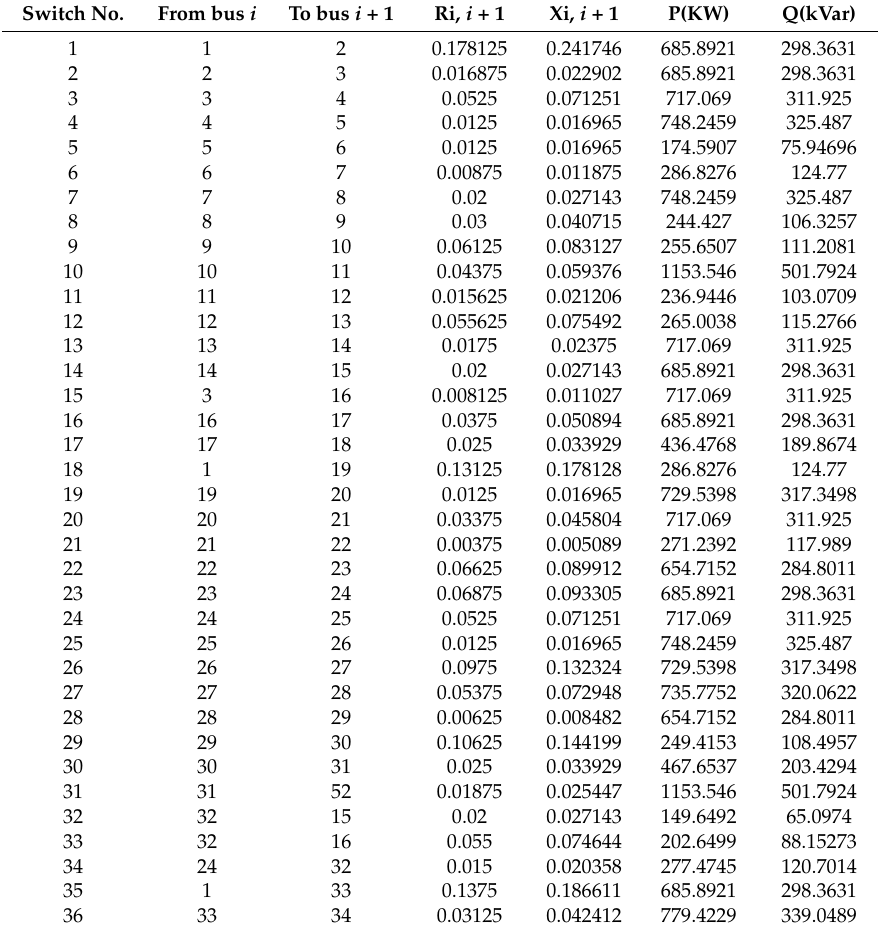
Table A1. Test data for a 78-bus